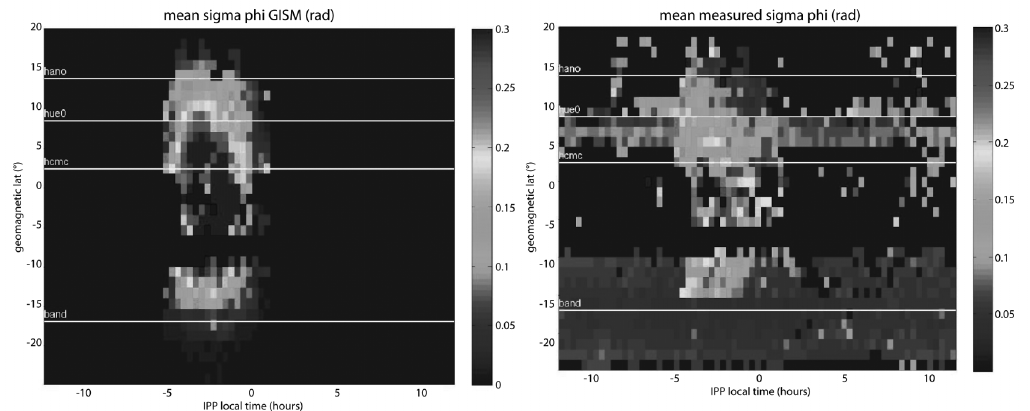
Fig. 8. Comparisons model-measurements in Vietnam and